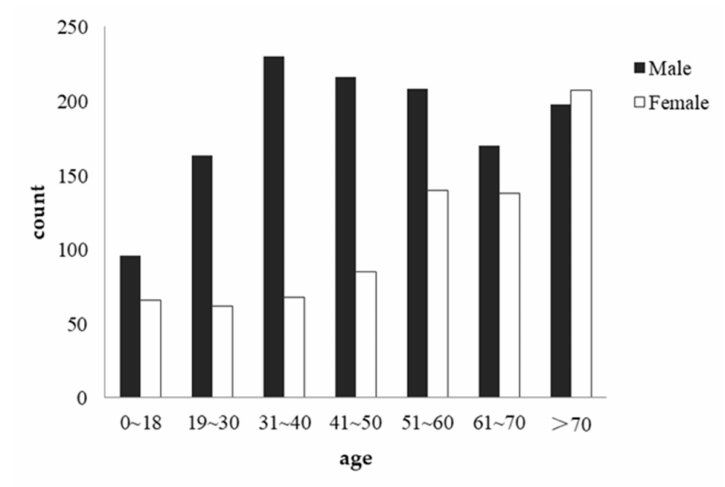
Figure 5. Collision frequency across different sex and age groups.